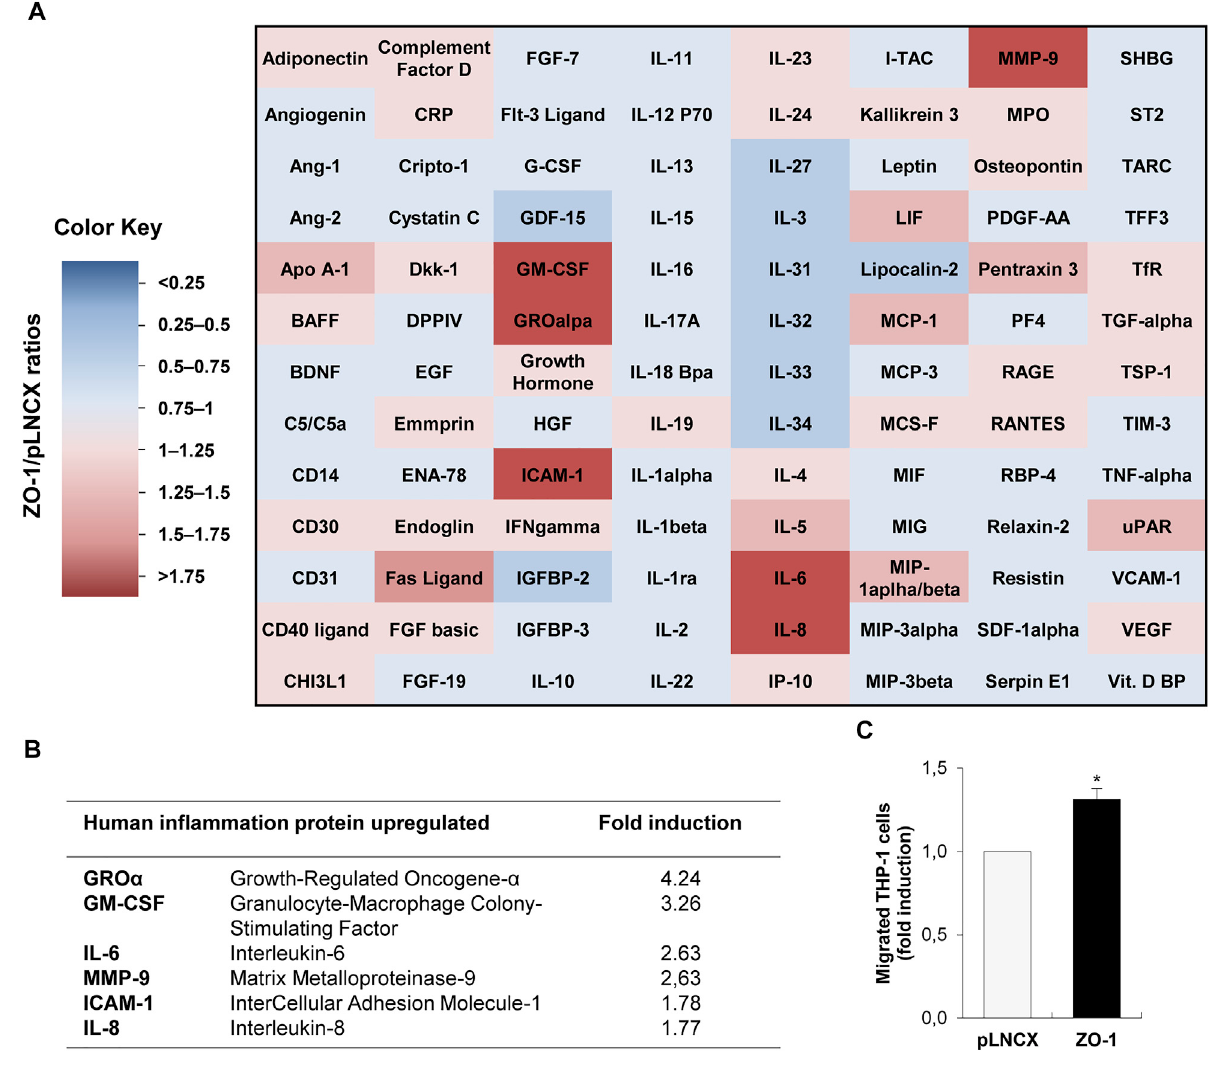
( Figure 1C ). These results together demonstrate that tumor cells expressing high levels of cyto-nuclear ZO-1 secrete soluble factors that can stimulate in fl ammatory cell migration in vitro .